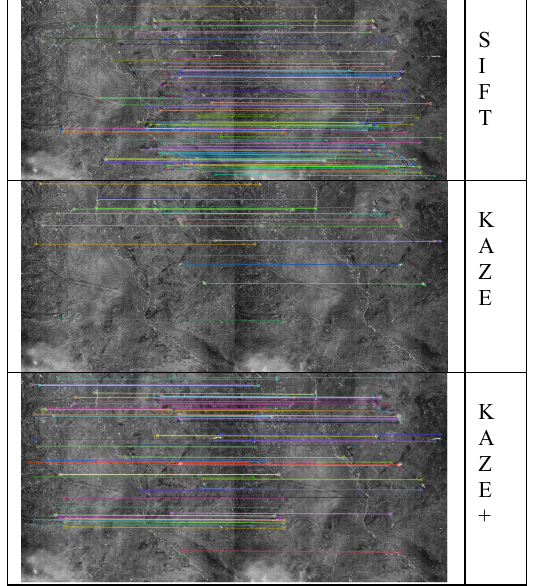
Figure 3. The matching result of ZY-3 stereo images(509*512) Algorithm